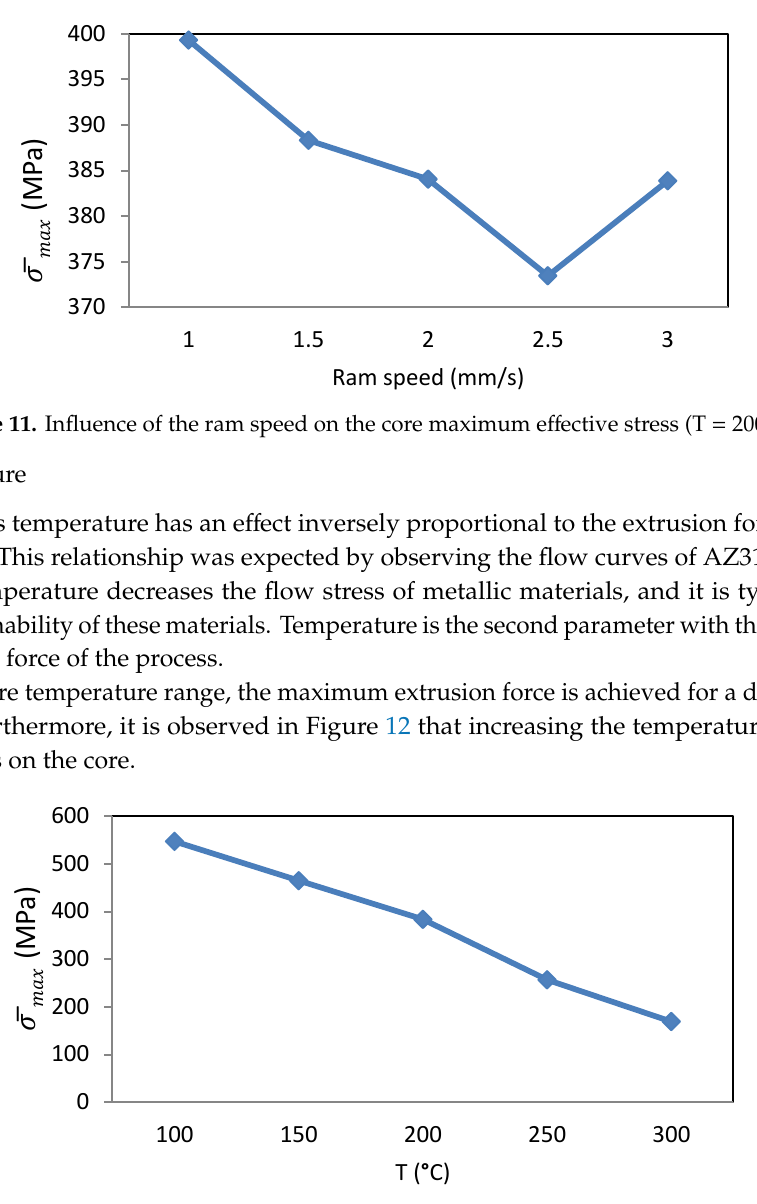
Figure 13. Influence of the temperature on the sleeve maximum effective stress. 3.2.5. Friction The friction at the interface between the container and the sleeve is the second most influential factor considered on the extrusion force of the process. In this work, it has been considered that the ring and core have been assembled with an interference fit, and due to the compression forces that they will suffer during the whole process, the friction between them would be maximum. Even so, in all of the simulations, it can be seen that there is a slip between the two at the beginning of the extrusion, being the part that always slides the AZ31B magnesium alloy. As can be seen in the graph of Figure 10e, as friction increases, the extrusion force necessary to carry out the process increases. Another effect observed on the extruded part is that as friction increases, the maximum effective stress on the core decreases, as shown in Figure 14.